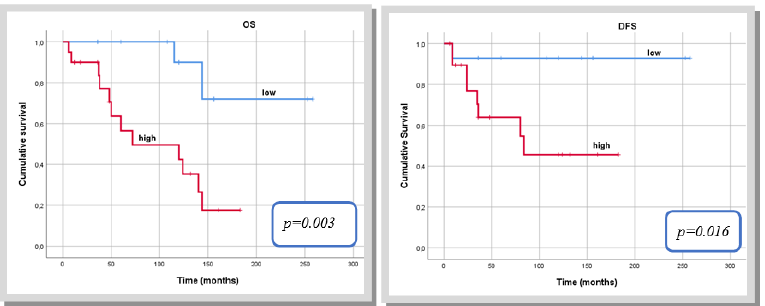
Figure 3. Kaplan–Meier curve for overall survival and disease-free survival according to the Figure 3. Kaplan – Meier curve for overall survival and disease-free survival according to the Tapias score. Tapias